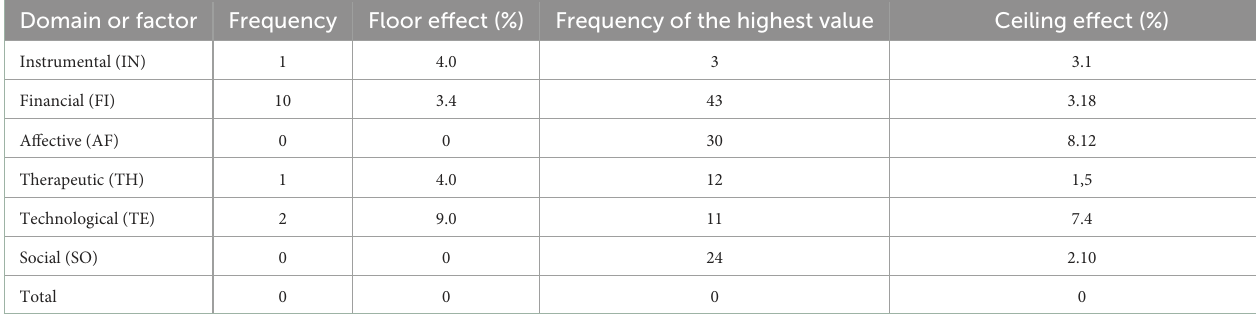
TABLE 7 The ceiling and floor effects in the